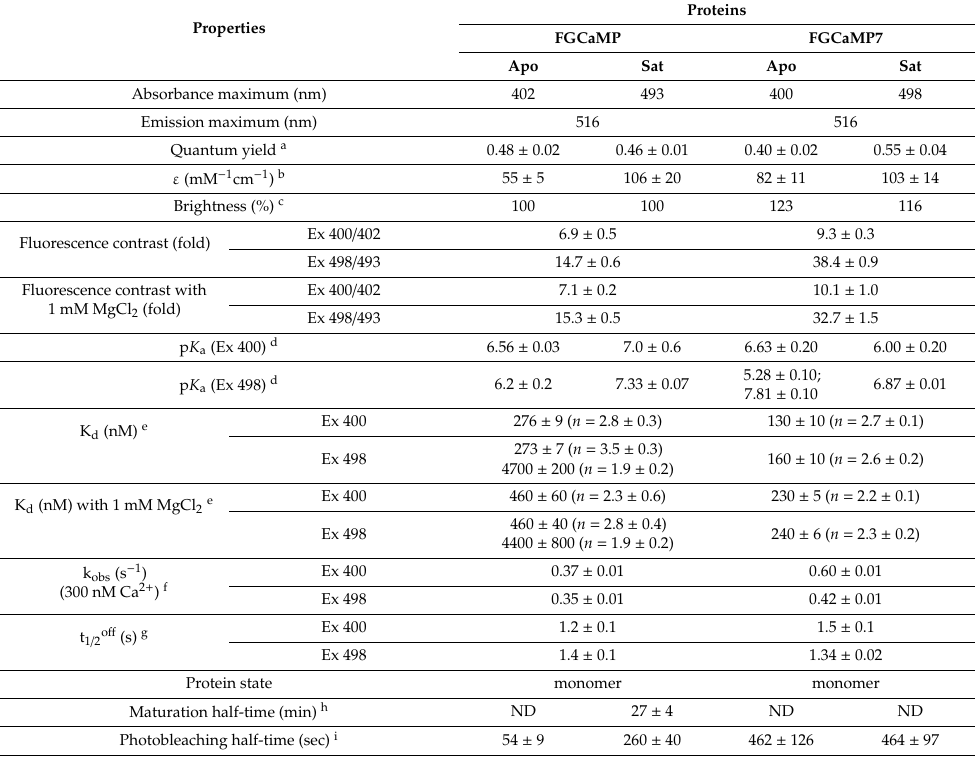
Table 1. In vitro characterization of FGCaMP7